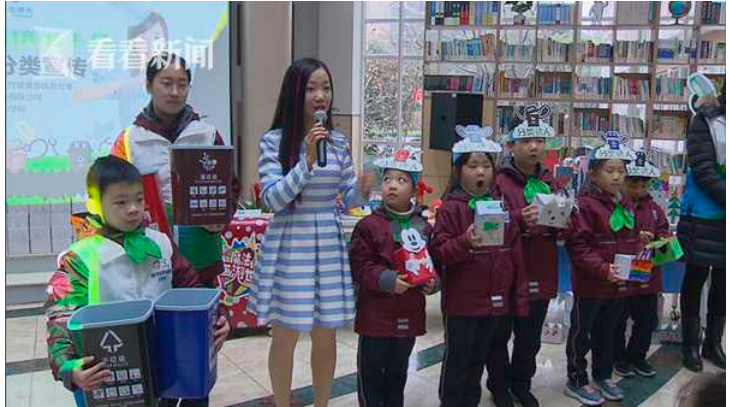
Figure 4. An educational activity on MSW classification in an elementary school in Changning District, Shanghai [27].